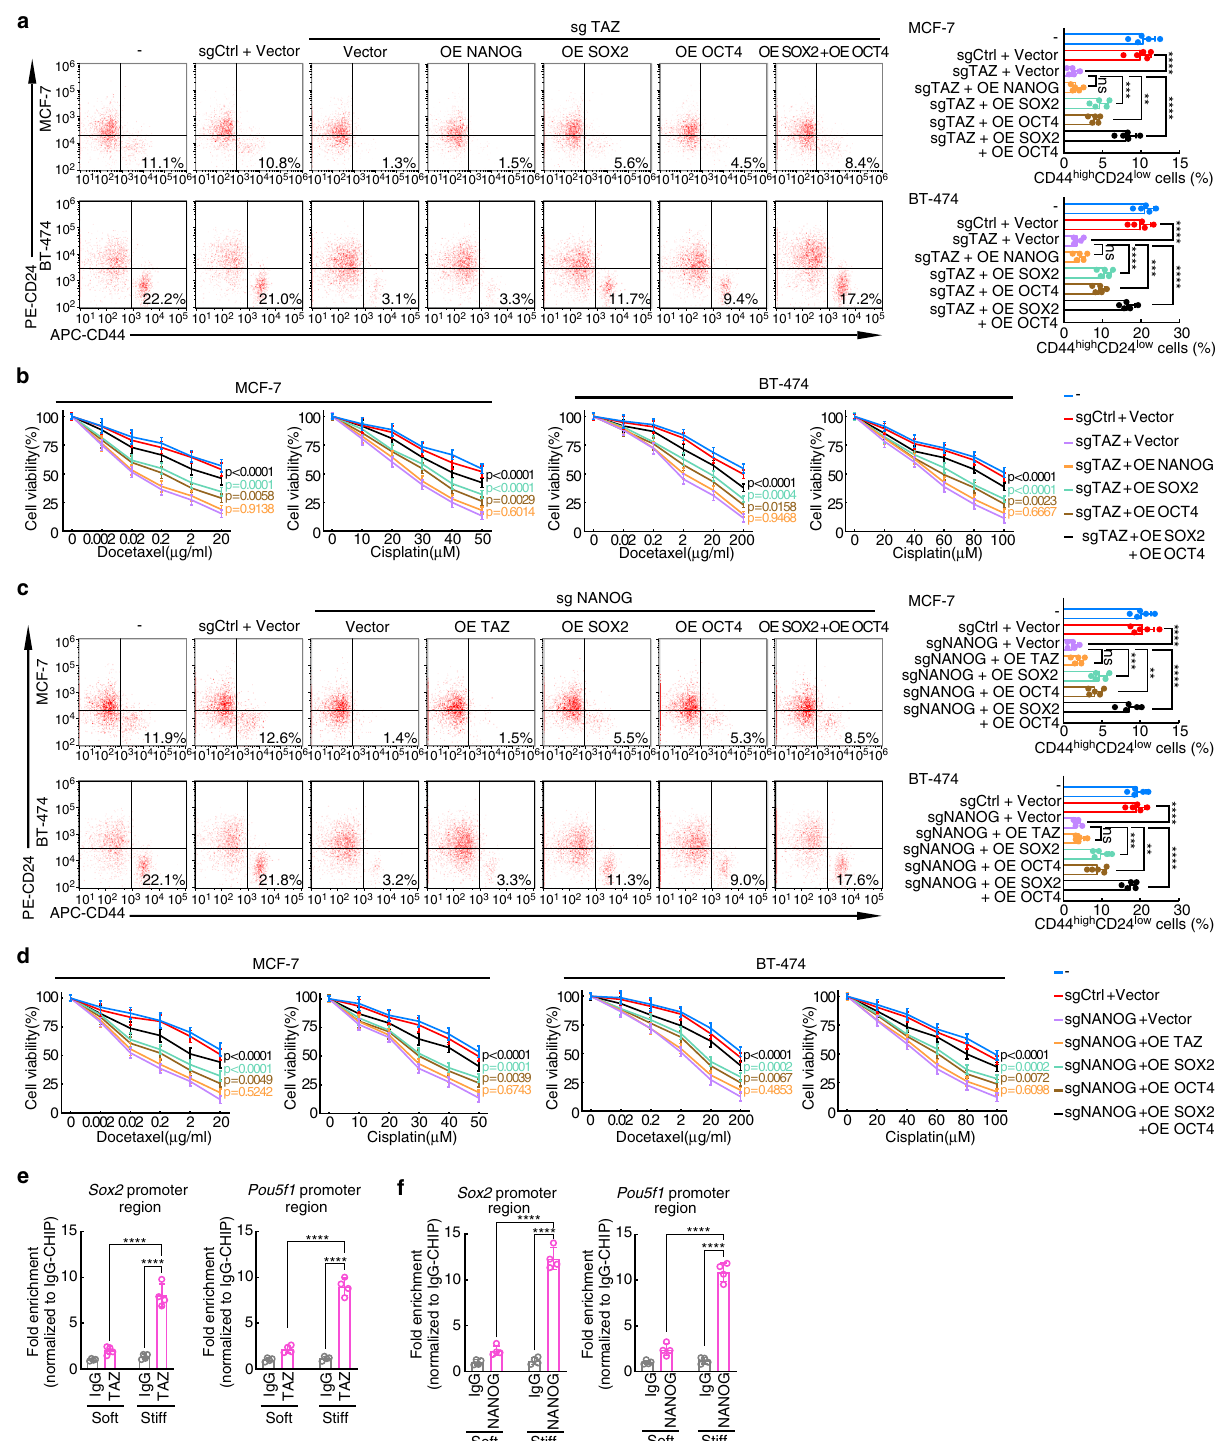
was visualized along the posterior margin of the fi eld of view. Initial gain settings were adjusted so that fat at all levels was displayed as a midlevel grey and solid mass was hypoechoic, while the skin was hyperechoic. Images were monitored in real-time and displayed in split-screen mode with the greyscale ultrasound B-mode and UE ima- gesontherightandleft,respectively.Asquareregionofinterest(ROI), which includes subcutaneous fat at the top of the breast, pectoral muscle at the bottom of the breast, and>5mm of breast parenchyma adjacent to the targeted lesion, was set for elastography